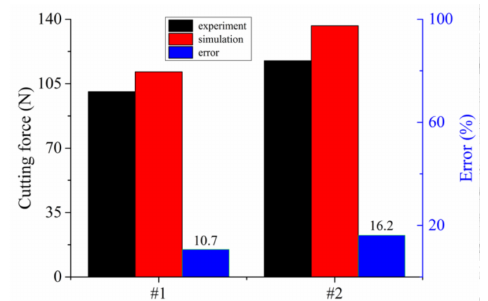
Figure 11. Comparison results of the verification tests between the simulated and experimental cutting forces.